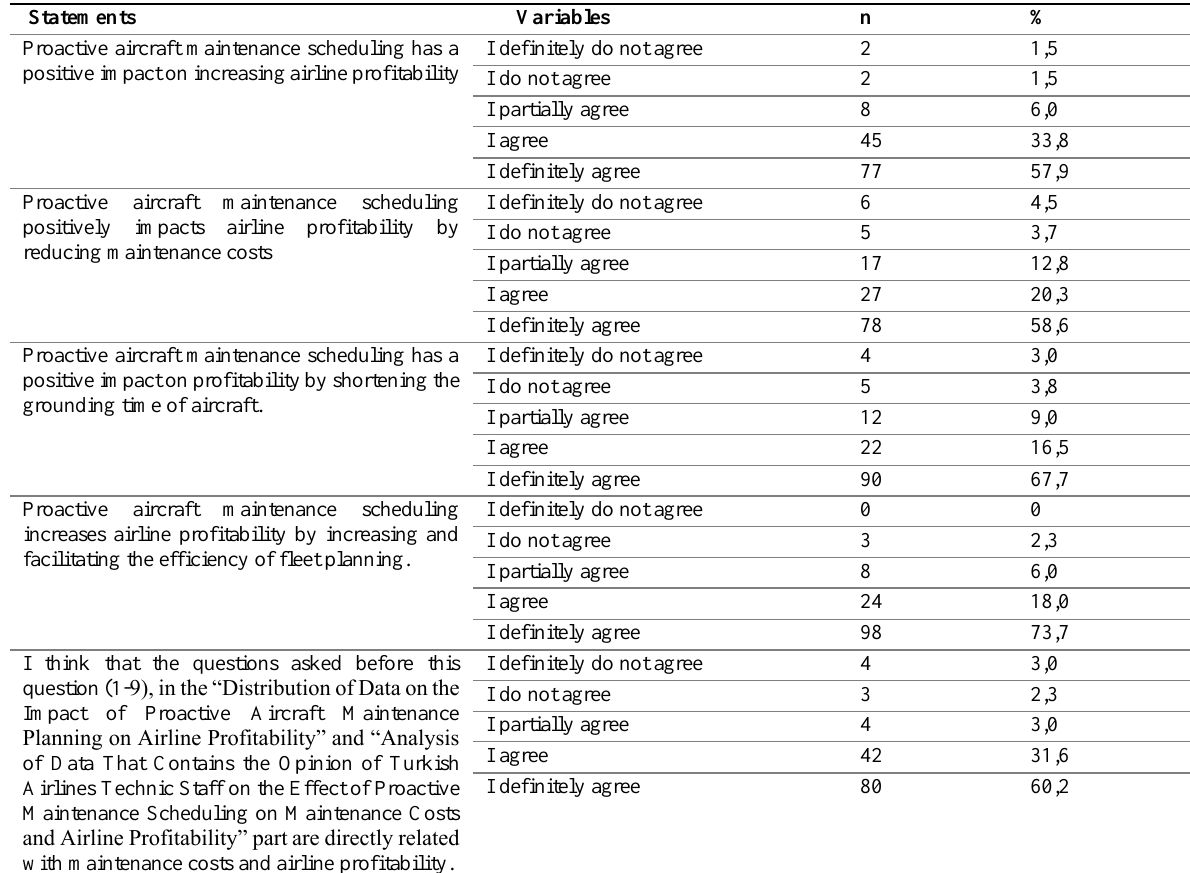
Table 6 : Distribution of Data on the Impact of Proactive Aircraft Maintenance Planning on Airline